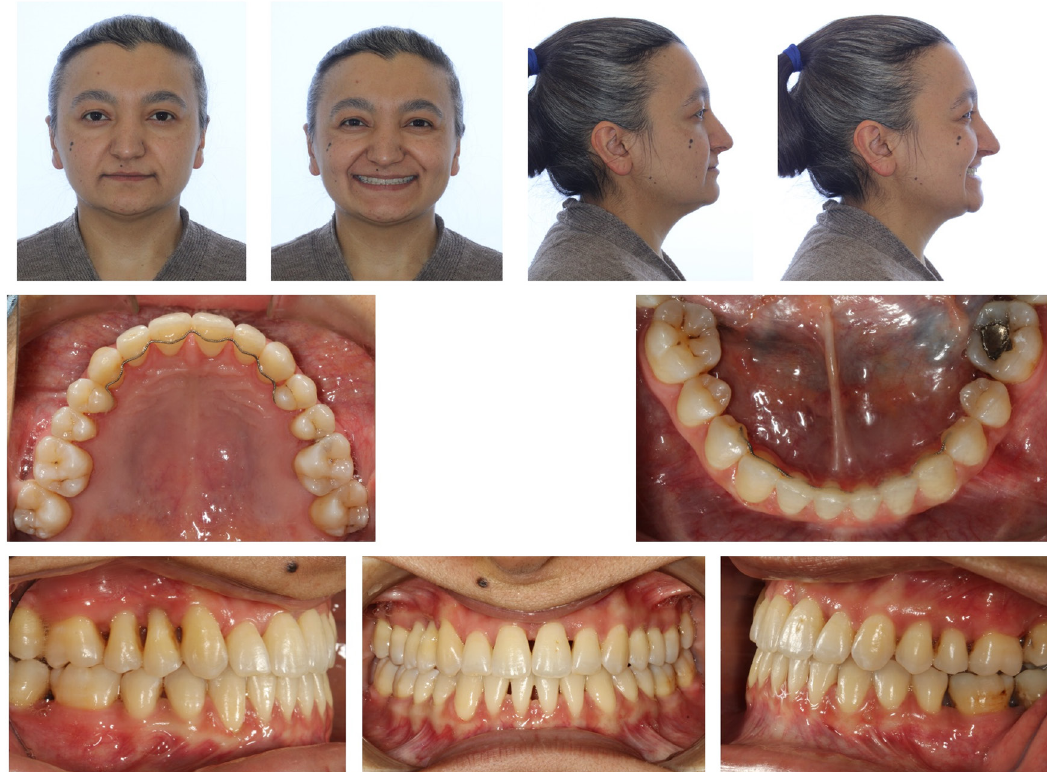
Figure 9. Extraoral and intraoral photographs at 2-year